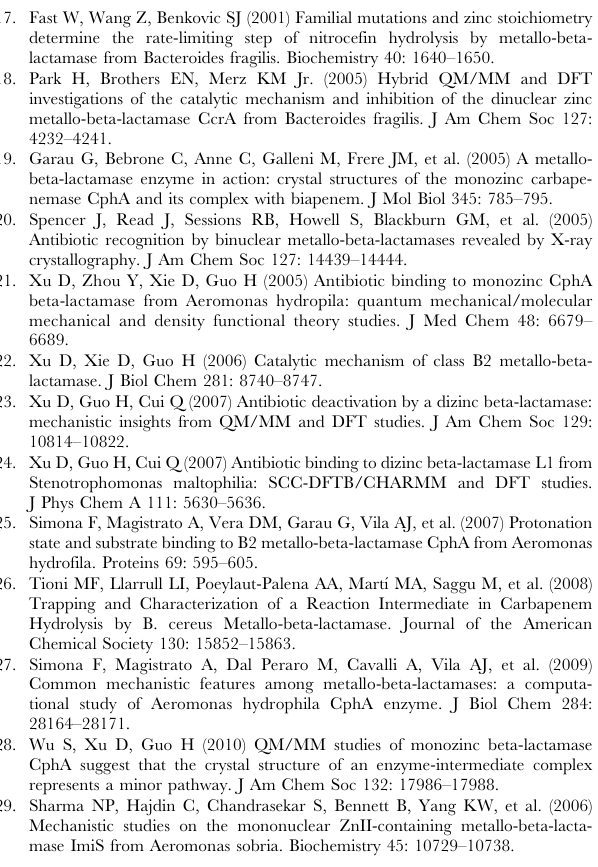
CV2’’. The ranges of Dihedral 1 values corresponding to Conformation A and Conformation B are highlighted in red and green, respectively, in the FES I panel. Figure S5 Free energy surfaces (FESs) of the hydro- xyethyl group rotations in the enzyme. The start point for all simulations was conformation A of hydrolyzed biapenem. FESs for the hydroxyethyl group rotations occurring with hydrolyzed biapenem in the active site of CphA in the configuration No. 4 of Table 1 were calculated under the same conditions and for the same collective variables as in Fig. S4 . Figure S6 Progression of the metadynamics FESs with time. The progression of the. FESs for the condition correspond- ing to deprotonated N4 and deprotonated C6 carboxylate is shown for different simulation times. Panels on the left refer to the metadynamics simulation that started from Conformation A. Panels on the right refer to the metadynamics simulation that started from Conformation B. A black dot in the 6 ns panels shows the actual value of the CVs at the beginning of the simulations. Figure S7 Stability of CphA and of its complex with hydrolyzed biapenem during the metadynamics simu- lations. In each panel, the blue trace represents the C a -RMSD of CphA at different times with respect to time 0; the red trace is